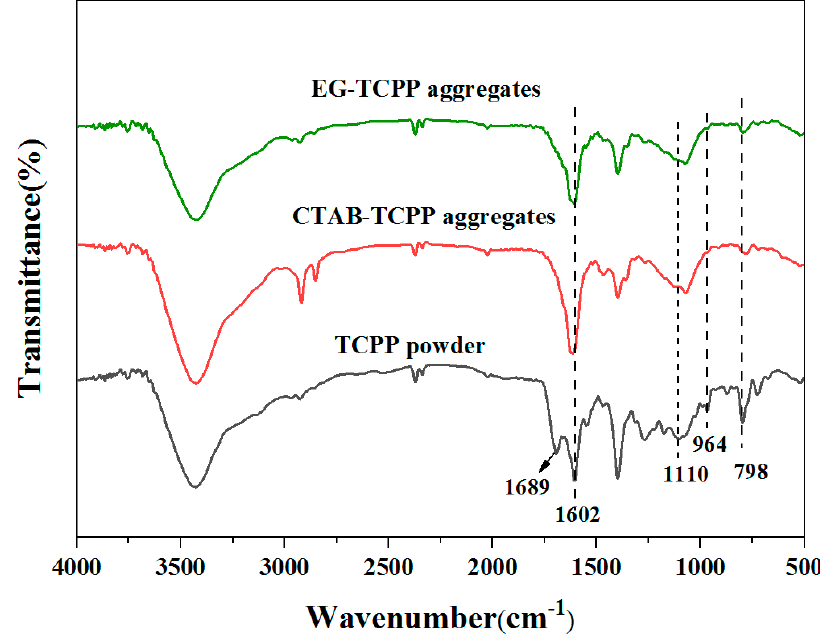
Figure 4. The FT-IR spectra of the different TCPP aggregates.